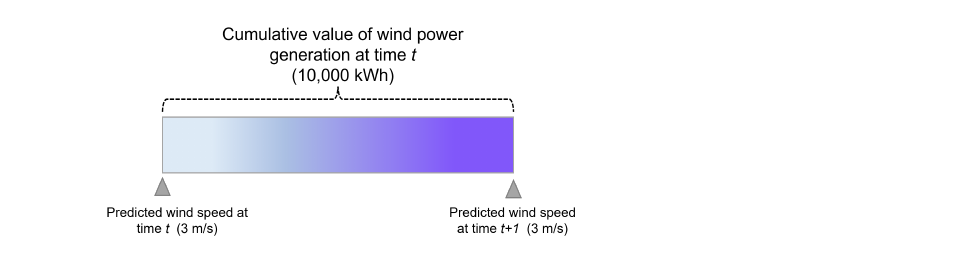
Figure 8. The predicted wind speed at time t and the predicted wind speed at time t + 1.